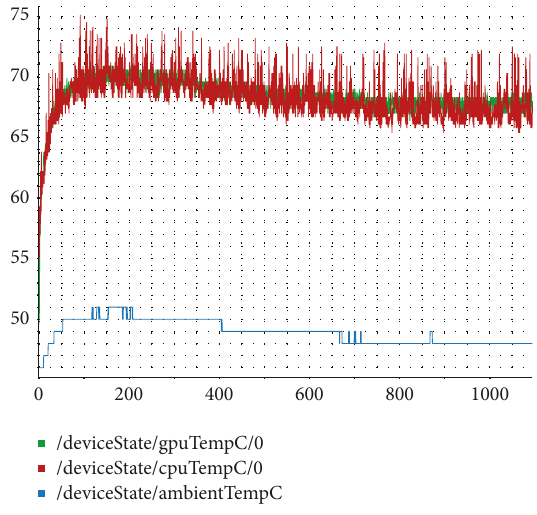
Figure 20: T1D4 temperatures.